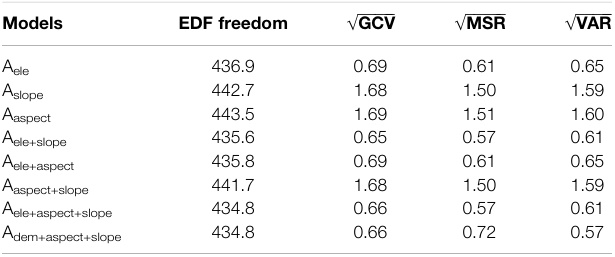
TABLE 4 | Comparisons of the ANUSPLIN model using different combinations of covariates. Models